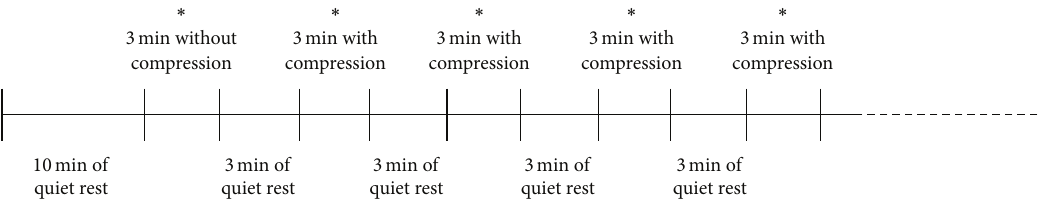
Figure 1: Experimental protocol. ∗ StO 2